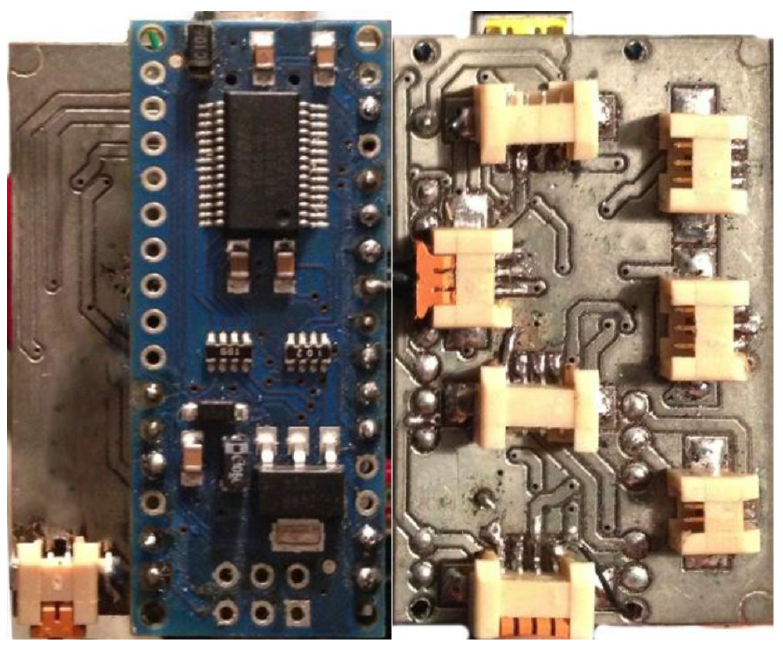
Figure 4. PCB prototype.